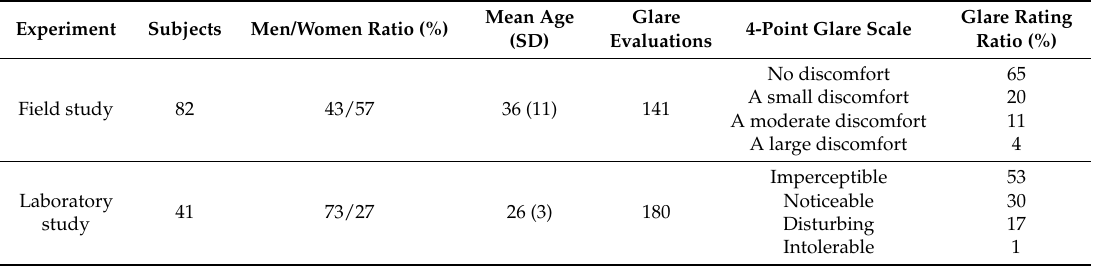
Table 1. Demographic and general information of field and laboratory